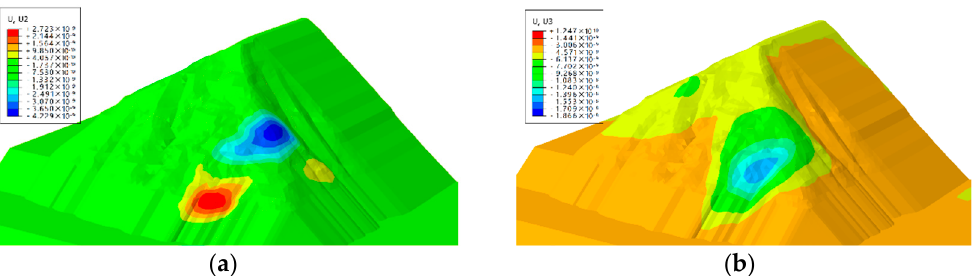
Figure 11. Distribution characteristics of initial displacement. ( a ) Displacement along slope. ( b ) vertical displacement.